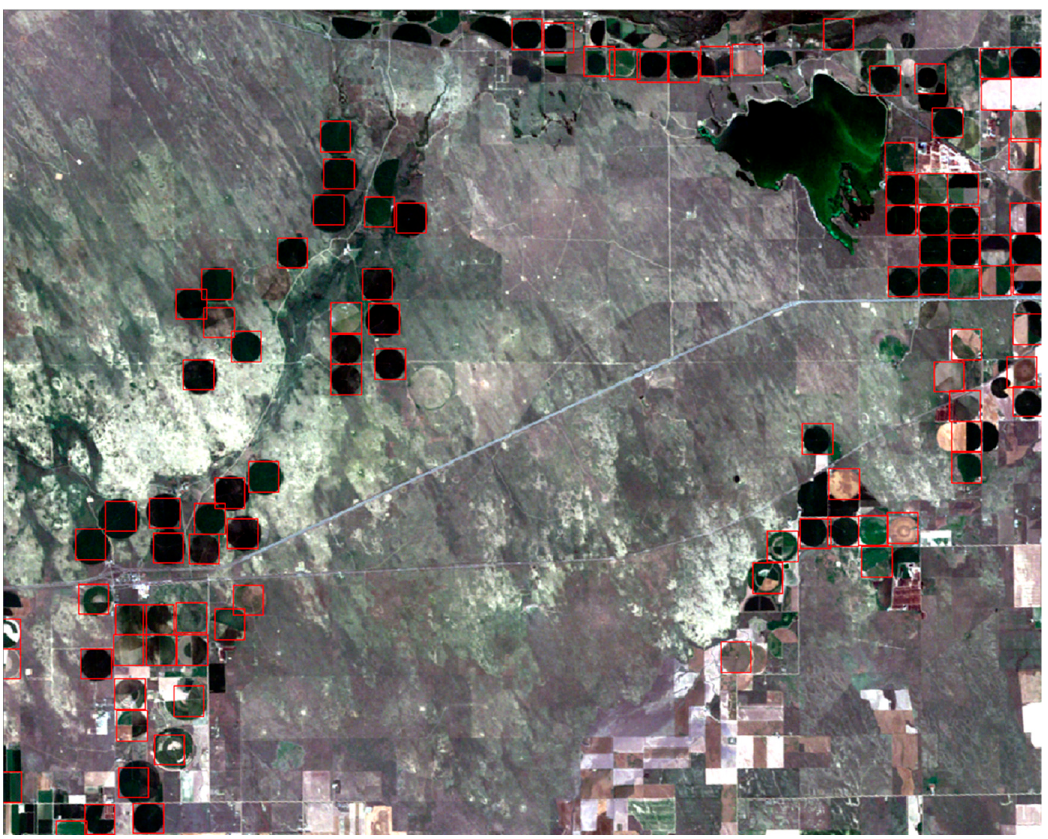
Figure 13. Images after the variance-based approach was applied. Center pivot irrigation systems are marked by squares.